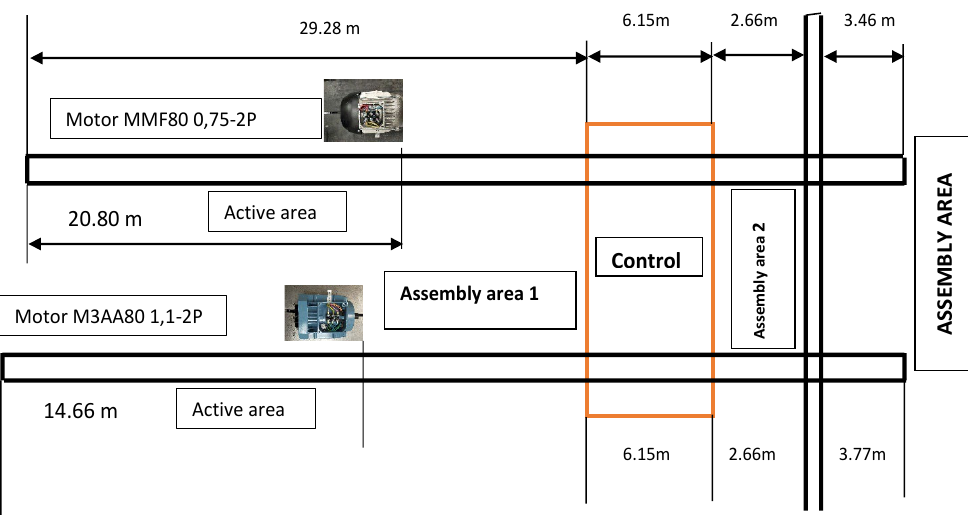
Figure 2. Determining the length of the assembly conveyors on which the IE4 asynchronous motors will be mounted.